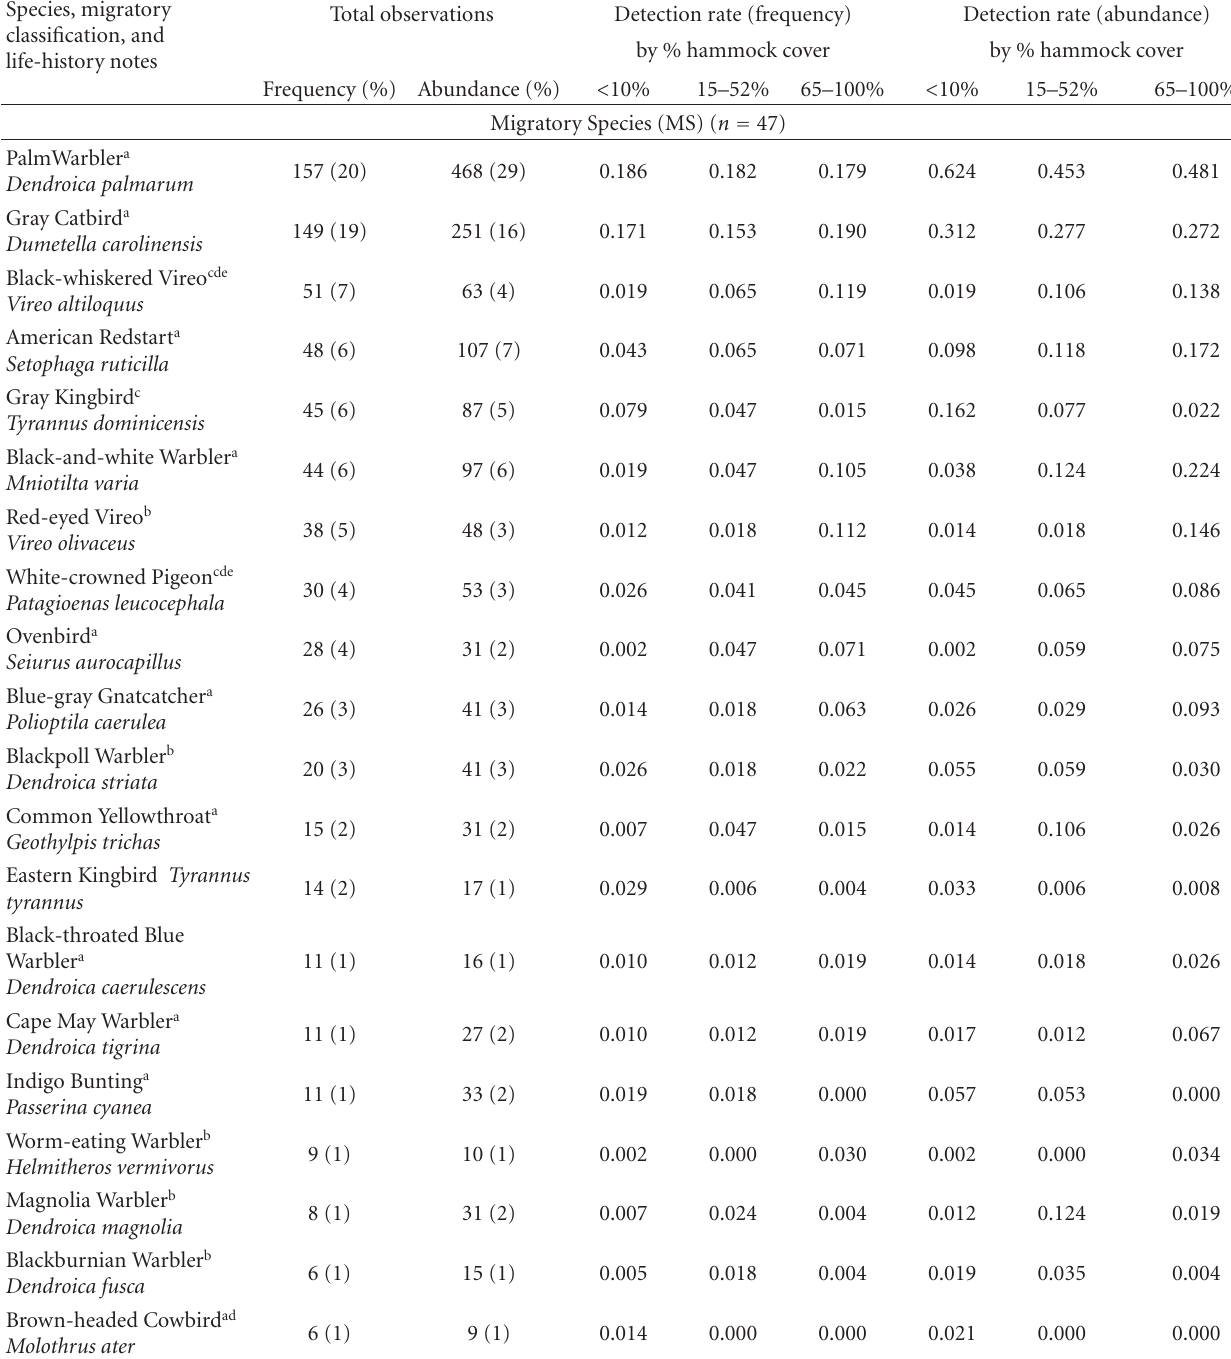
Table 2: Migratory (MS) and year-round resident (YR) species recorded during point counts in the Florida Keys during March–May 2004 and 2005 in residential and conservation areas with varying levels of intact native hammock forest cover. Species are listed from most frequently to least frequently observed during point counts. Total observations are reported for each species as frequency (number of point counts in which species was recorded) and abundance (total number of birds recorded). Percent frequency and percent abundance are provided in parentheses and reflect the relative frequency and abundance of each species within its migratory classification. Detection rates (frequency and abundance) are provided for each species for point count sites categorized by the amount of native hammock cover present: < 10% (42 sites, n = 420 point counts), 15–52% (17 sites, n = 170 point counts), 65–100% (27 sites, n = 268 point counts). Life history details for each species are provided in footnotes. Species with known resident populations were classified as resident species, even if migratory individuals are reported to occur. Classification of migratory and resident status was based on The Birds of North America Online [17] and, Florida Fish and Wildlife Conservation Commission [18]. Nomenclature is consistent with the American Ornithologist’s Union Check-list of North American Birds